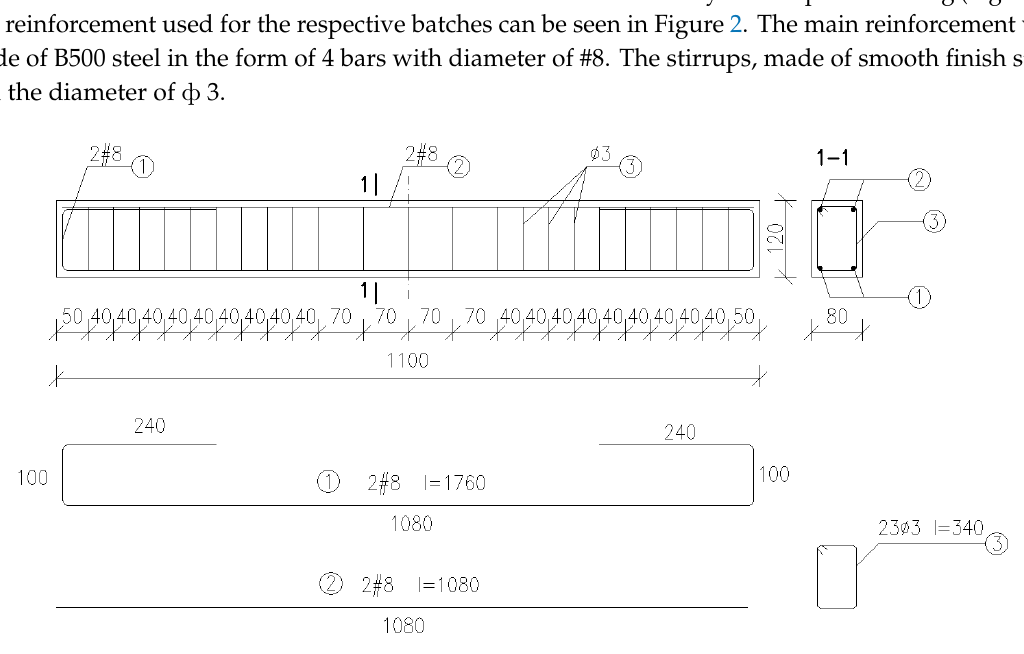
Figure 2. The scheme of reinforcement for beams.